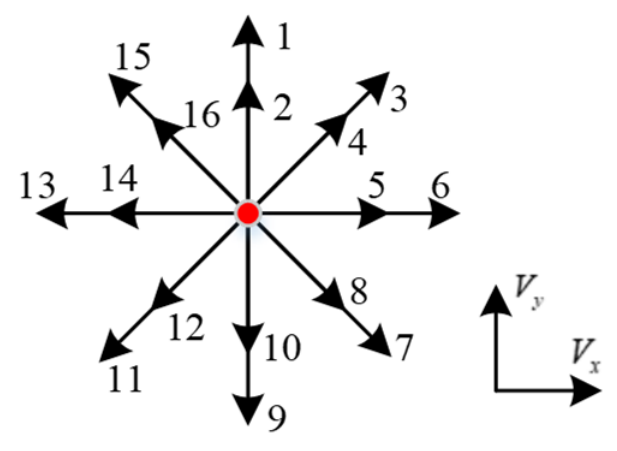
Figure 2. The diver multidirectional movement model set. In Figure 2, the red circle represents the position of the diver target at the current moment, and the direction indicated by the eight arrows is the possible predicted direction of the target. Each direction includes two uniform linear motion models with speeds of 0.75 and 1.25 times the target speed range at the previous moment. V x and V y denote the velocity direction of the target state estimation at the current